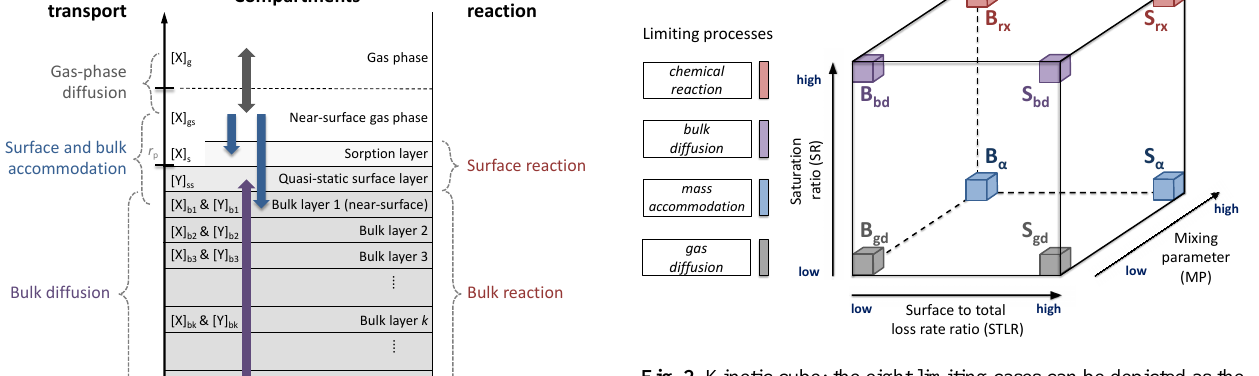
Fig. 2. Kinetic cube: the eight limiting cases can be depicted as the vertices of a cube in which every direction refers to a classification criterion (STLR, SR, MP). They are classified into four types of limiting behaviour: limitation by chemical reaction, bulk diffusion, mass accommodation (including surface and bulk accommodation) and gas